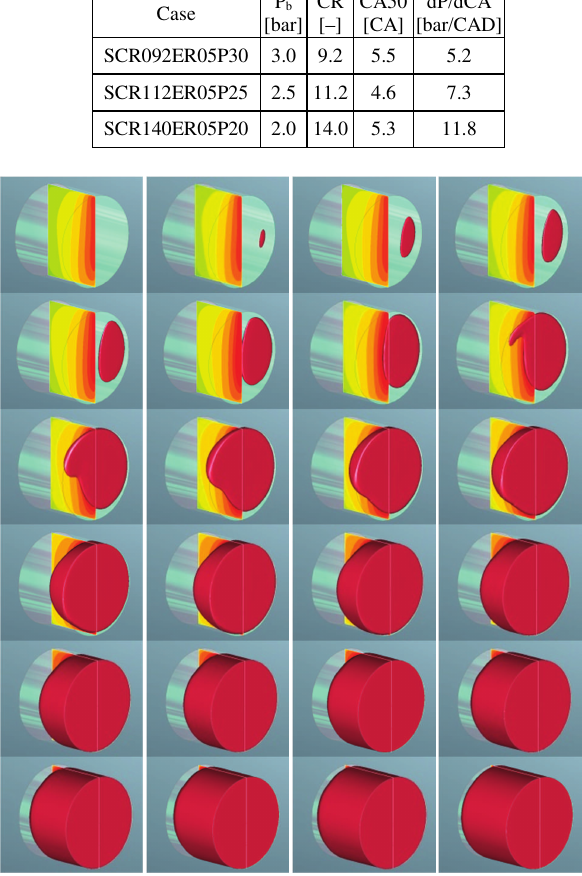
Fig. 12. Pressure trace and ROHR for syngas and CAI mode Results of pressure trace, ROHR and visualization of CAI combustion are given in Fig. 12 and Fig. 13. It is inter- esting to see difference between CAI combustion mode and MPI dual-fuel mode. In case CAI mode mixture always ignites at the exhaust-side piston in a region of high tem- perature EGR. Then flame propagates from the exhaust- side piston to the intake-side piston through stratified mix- ture. Because there is no secondary auto-ignition, there is also no secondary peak in the heat Fig. 11. Visualisation of ignition and combustion for case SCR080ER05P30 (syngas MPI)